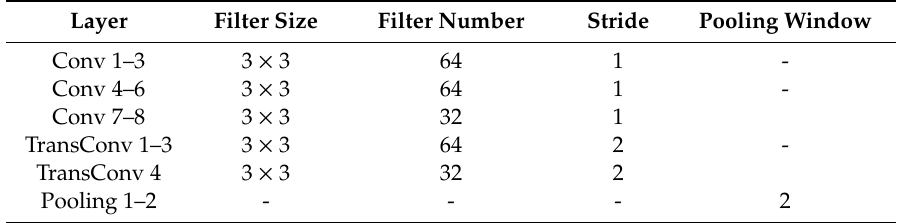
Figure 2. The proposed SRM CNN model. Figure 2. The p roposed SRM (cid:2887)(cid:2898)(cid:2898) model. Table 1. Parameters of the SRM CNN Table 1. Parameters of the SRM (cid:2887)(cid:2898)(cid:2898) model.